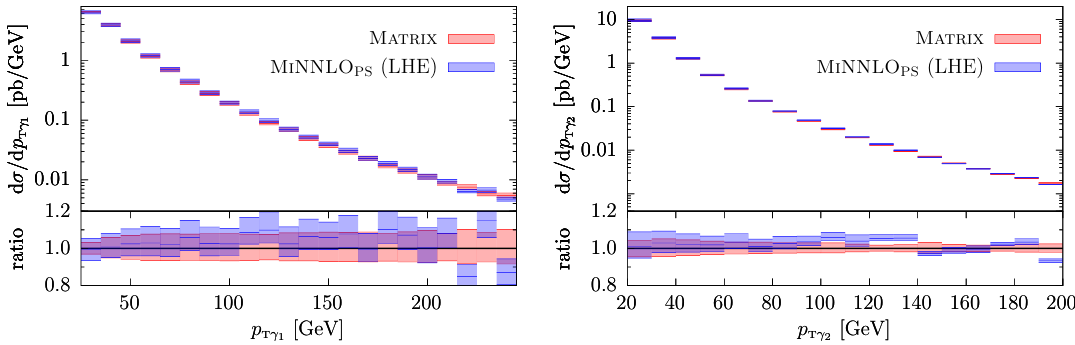
Figure 6 . Comparison between the distributions obtained from the fixed-order calculation from Matrix and the results after the generation of the hardest emission, for the transverse momentum of the hardest and next-to-hardest photon.